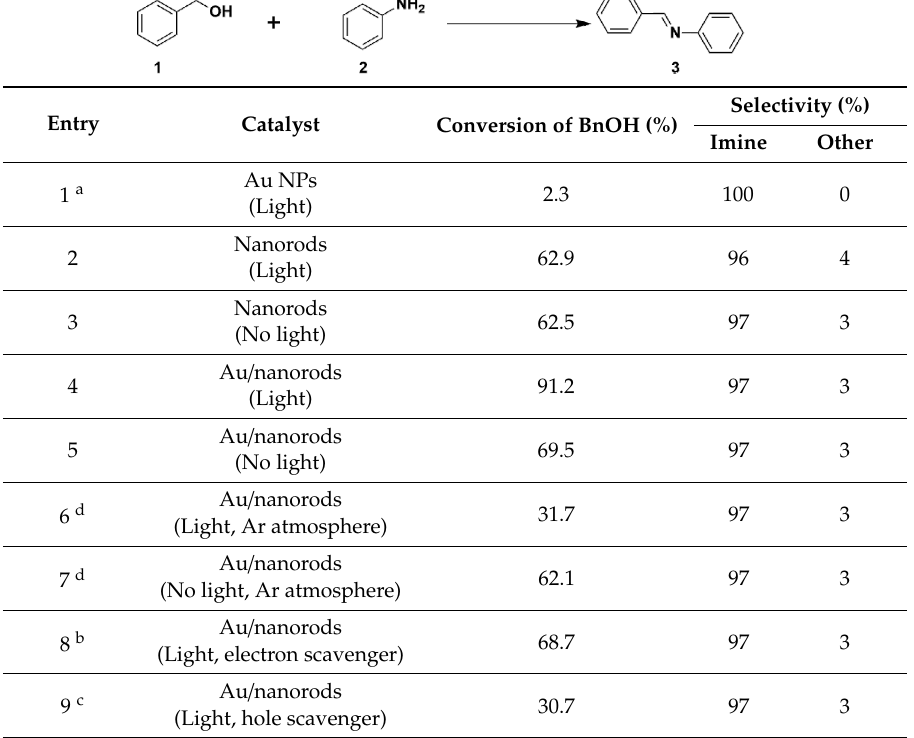
Table 1. Conversion and selectivity for the tandem conversion of benzyl alcohol into imines as a function of the catalysts and reaction conditions.